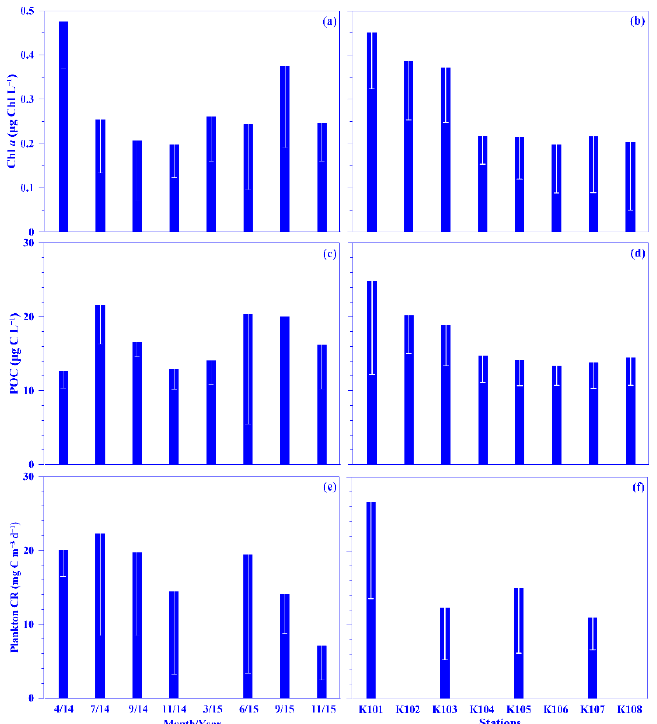
Figure 4. Temporal and spatial variations of the mean values of chlorophyll a (Chl a ; ( a , b )), particulate organic carbon (POC; ( c , d )), and plankton community respiration (Plankton CR; ( e , f )) across the KTV1 transect of the Kuroshio. The depth-normalized integrated value over 100 m water column of each variable at each sampling station was used for the mean values. The mean values were av- eraged across all stations of the KTV1 transect for each sampling period or across each station of the KTV1 transect for all sampling periods. The standard deviations are illustrated as vertical white lines with caps.